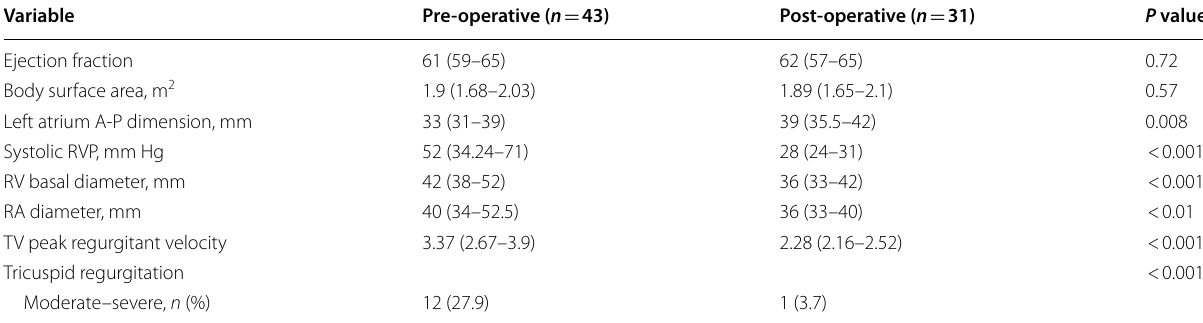
A-P Lung transplant surgery: anterio-posterior, RVP Right ventricular pressure, RV Right ventricle, RA Right atrium, TV Tricuspid valve